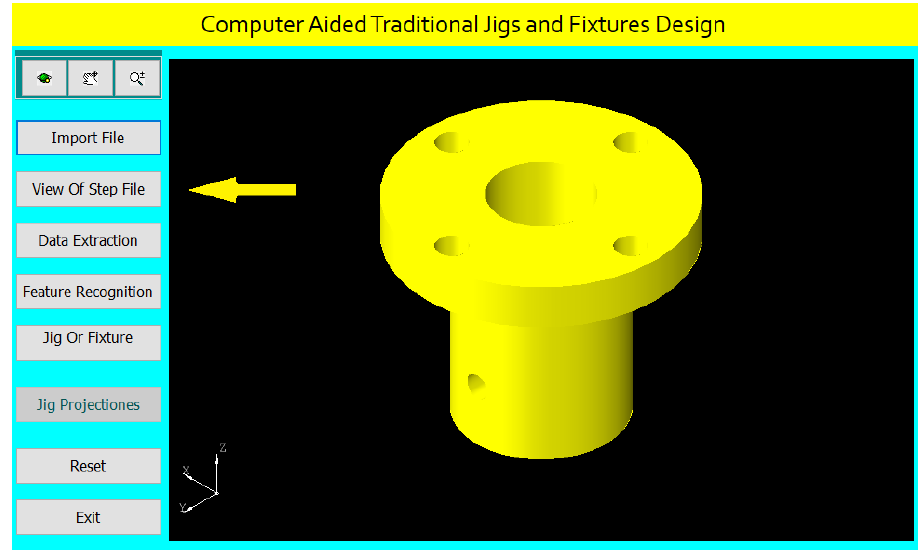
Figure 9. The second screen of the system interface.